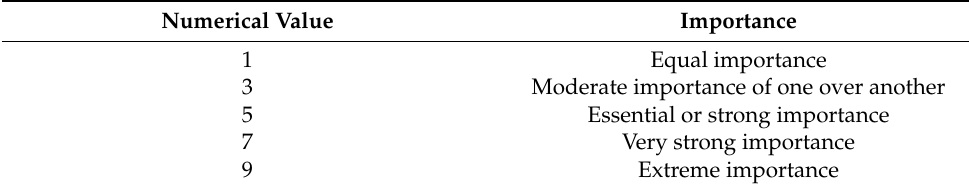
Table 7. Relationship between numerical value and